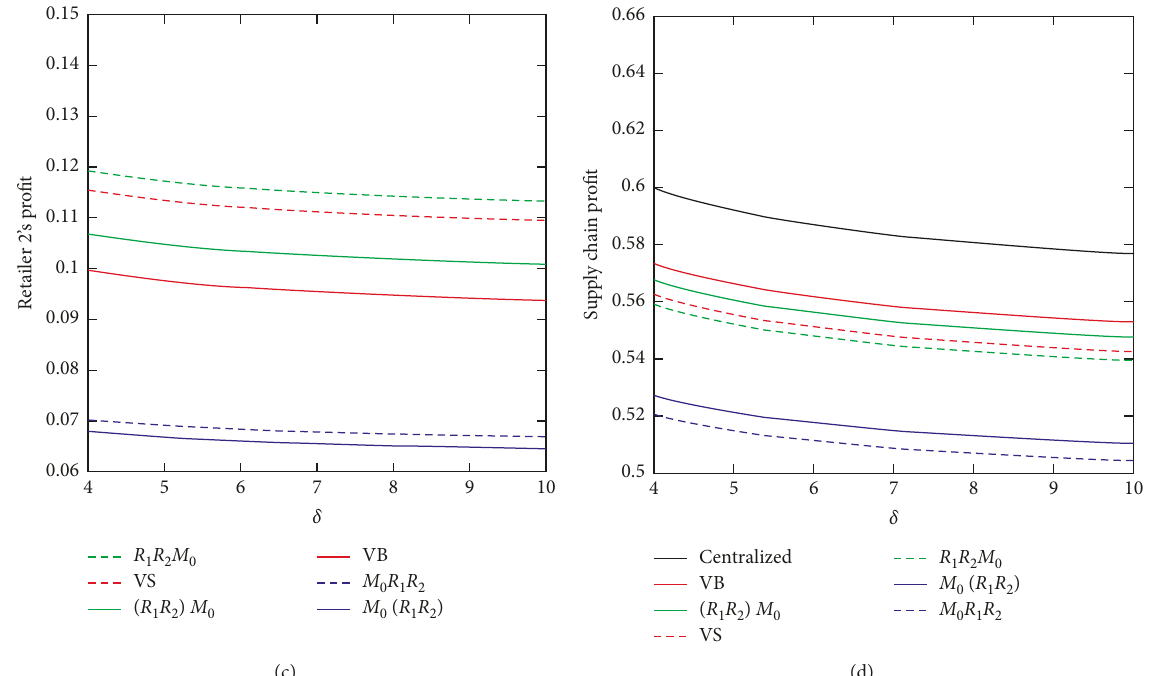
Figure 8: Effect of δ on the SC profit in centralized and decentralized models.